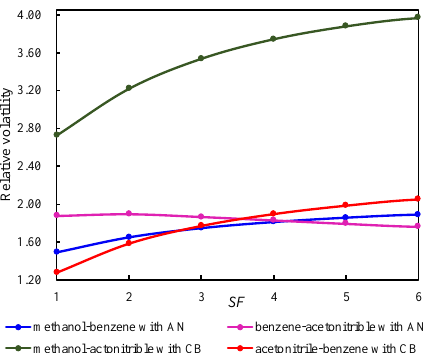
Figure 3. Variations of relative volatilities at different solvent-to-feed ratios.